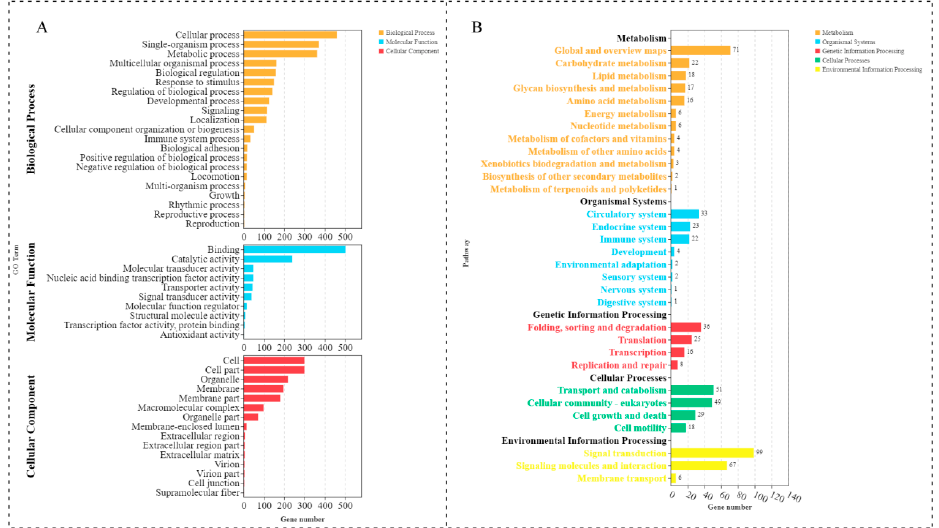
Figure 5 . GO and KEGG enrichment analyses for the DE lncRNA cis-targeted genes. ( A ) Histogram of significant GO enrichment in DE lncRNAs. Yellow represents biological processes, red represents cellular components, and blue represents molecular functions. ( B ) KEGG pathway enrichment in DE lncRNAs.